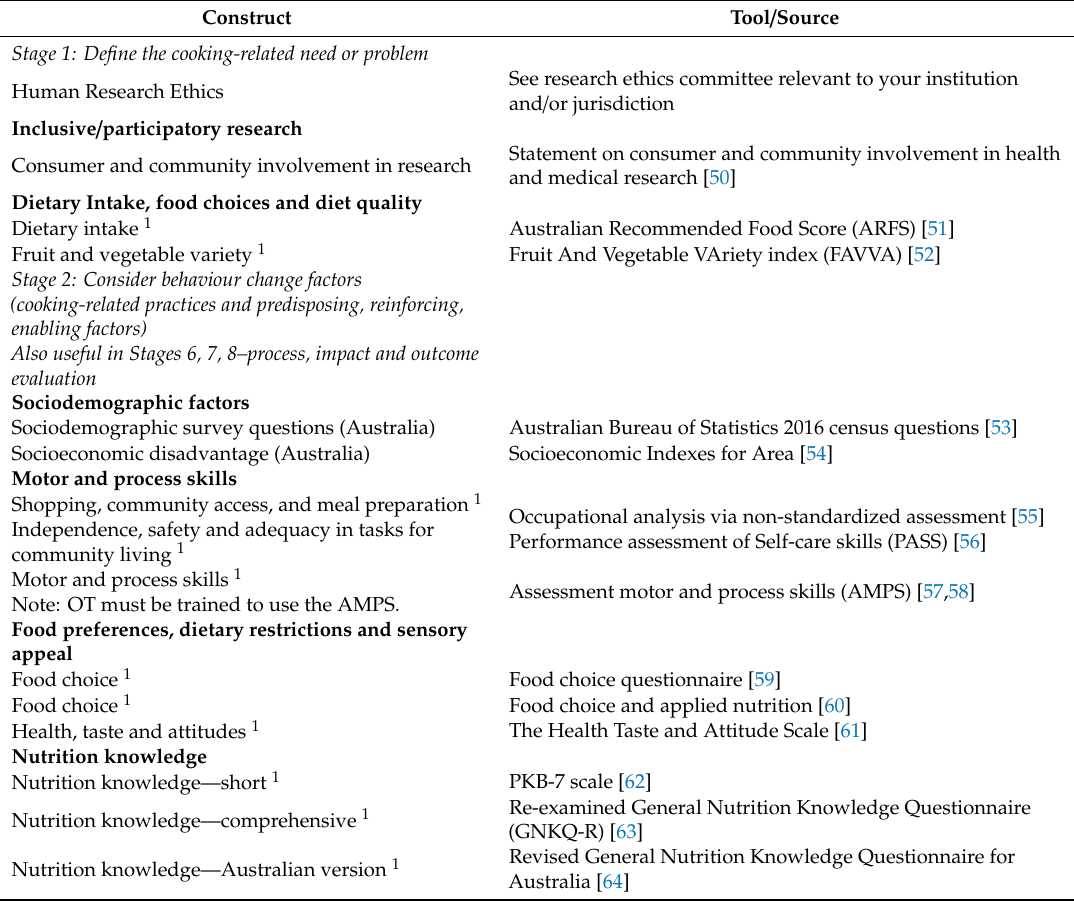
Table A1. An inventory of resources to assist cooking program